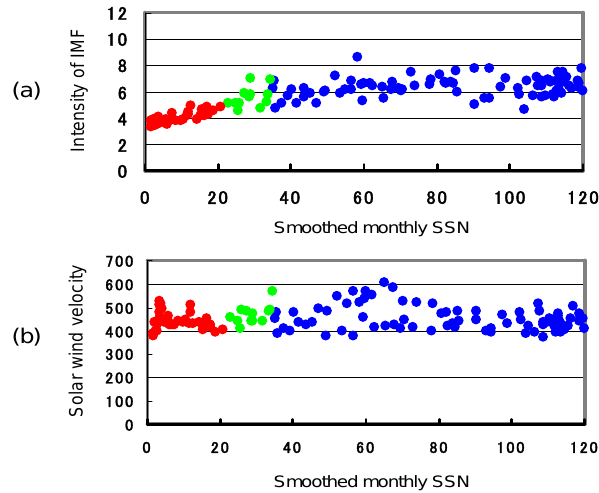
Fig. 9. (a) Scatter plot between monthly average of the total inten- sity of the interplanetary magnetic field and the monthly smoothed sunspot number. (b) Scatter plot between monthly average of the solar wind velocity in the sun-earth direction and the monthly smoothed sunspot number. Red, green and blue circles represent data for the years 2006 through 2008, 2005, and 1998 through 2004,